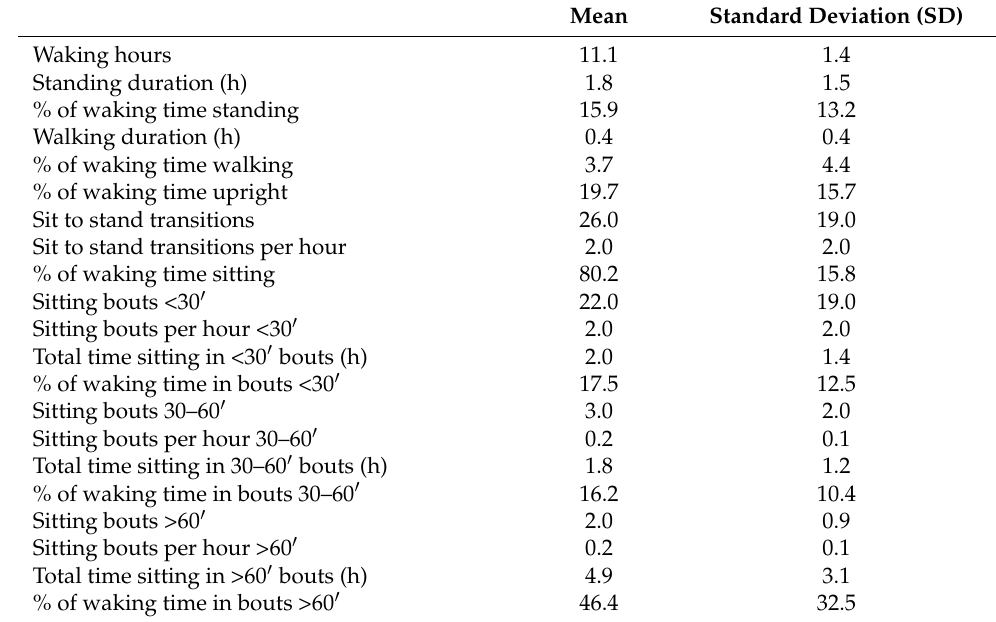
Table 2. SB and WTMB information of five nursing homes (NHs) from Osona, Spain